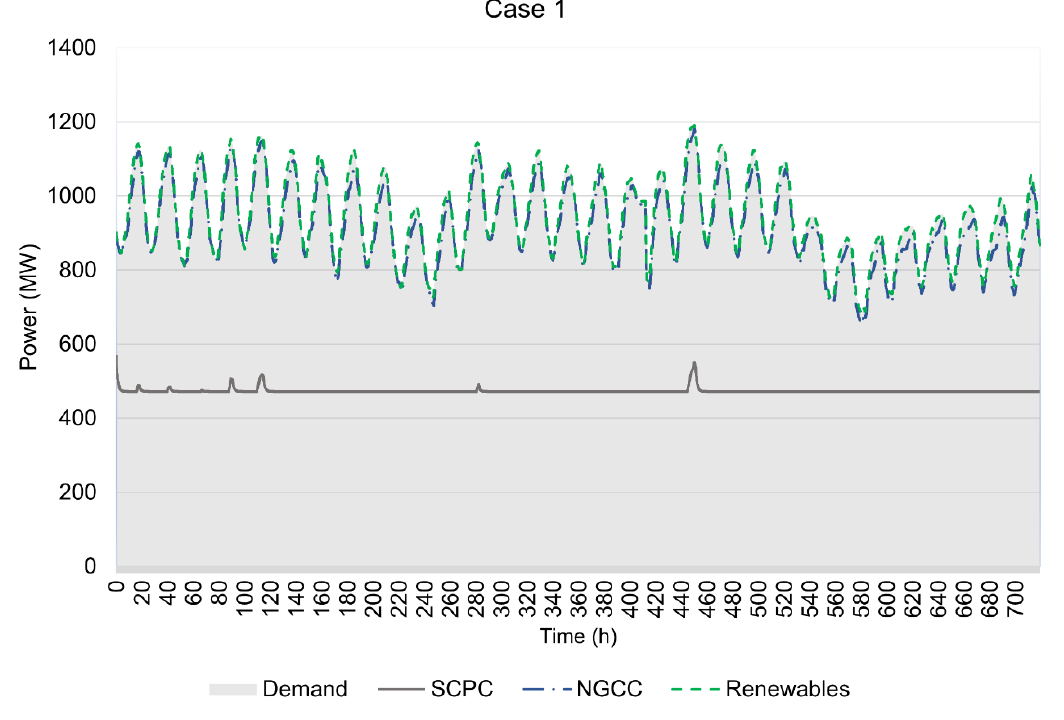
Figure 10. Power dispatch optimization result for Case 2.